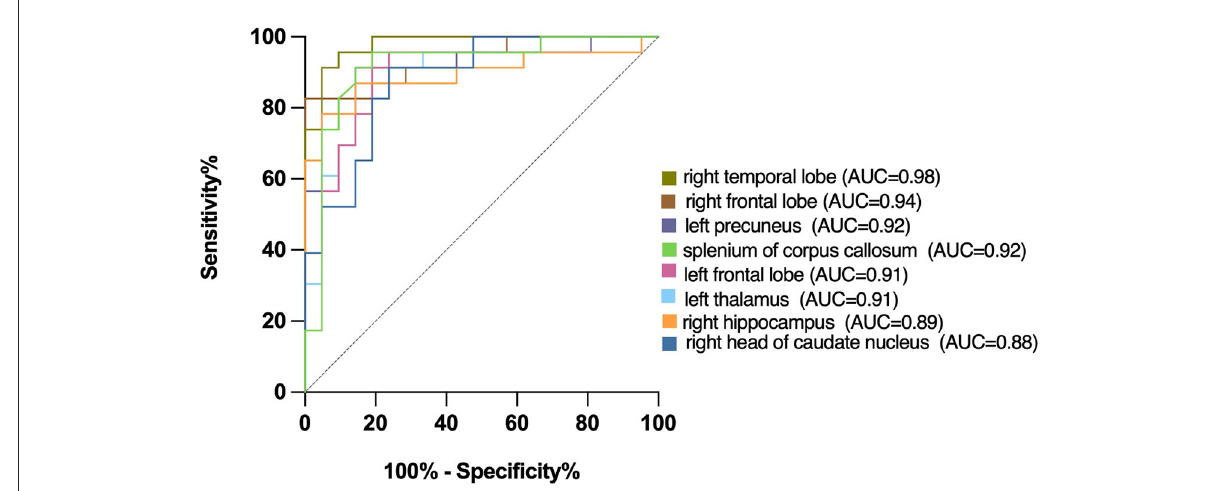
FIGURE3 Receiver operating characteristic (ROC) curves for T1 relaxation times, distinguishing CI group from Normal group. T1 relaxation time in the right temporal lobe was identified as a good individual discriminator of cognitive impairment after acute cerebral infarction from healthy controls using ROC analysis; at the optimal cut-off T1 relaxation time of 887.4, sensitivity and specificity were 91.30 and 95.24%, respectively, with an AUC value of